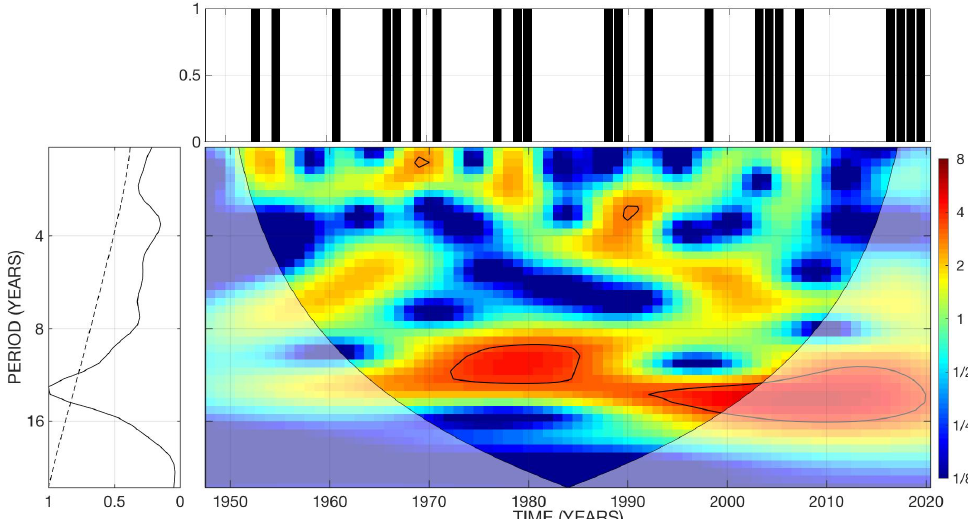
Figure 1. Time-frequency wavelet results of category 5 Atlantic hurricanes between 1950 and 2021. The digital time series for category 5 Atlantic hurricanes is shown in the upper panel. The global wavelet spectrum is shown in the left panel. The central panel shows the calculated wavelet Power Spectral Density (PSD) in normalized units adopting the red-green-blue color scales. The Cone Of Influence (COI, “U”-shaped curve with shaded outer zones) shows the possible edge effects in the PSD. The time-frequency regions with wavelet spectral power detection above 95% confidence level are marked with thin black